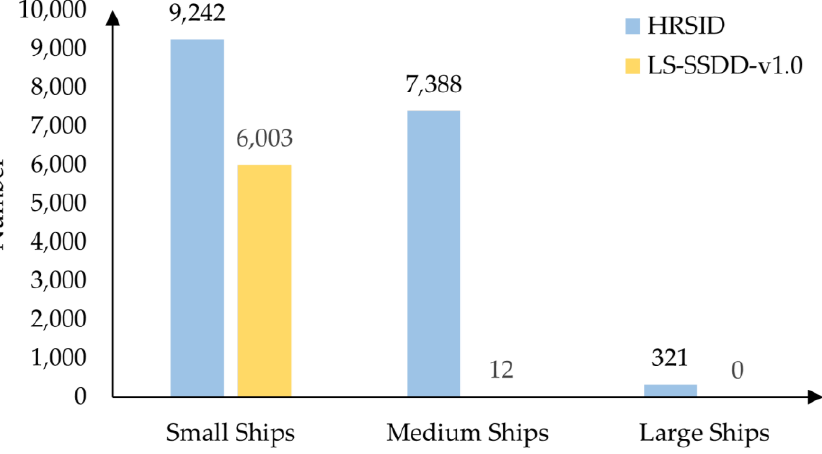
Figure 6. Comparison of the number of ships of three sizes in the two datasets.